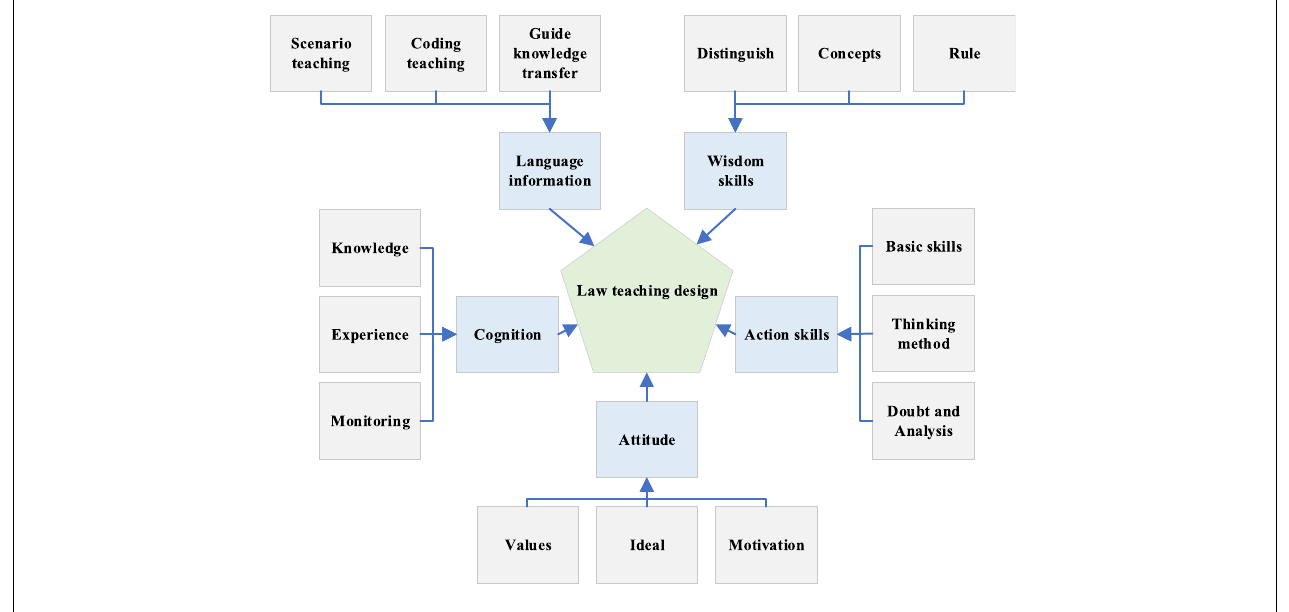
FIGURE 2 | Detail of legal instructional design. TABLE 1 | Contents of the language information module.